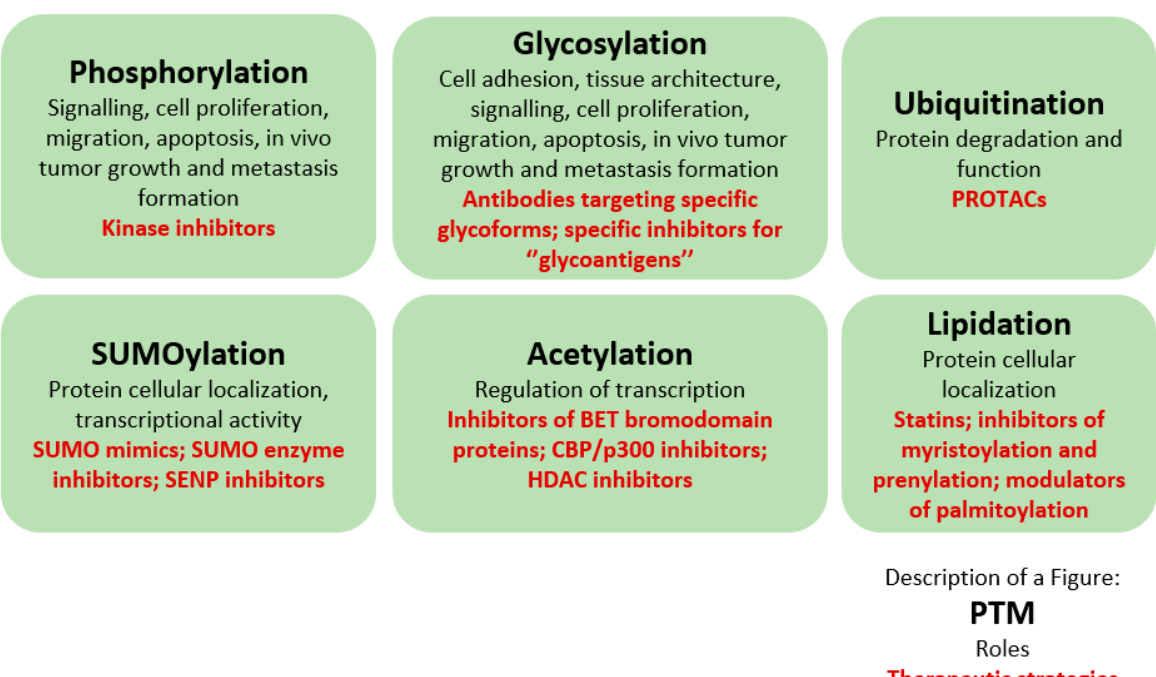
Figure 2. Post-translational modifications, their involvements in cellular processes and therapeutic opportunities. Since kinases are the driving proteins in both cancer cell growth and dissemination, tempts to develop novel anti-cancer drugs. A proteolysis targeting chimera (PROTAC) used in oncology as a first or second line therapy in various cancer types [420]. In prostate cancer, tyrosine kinase inhibitors targeting signaling pathways of EGFR, VEGFR, c-SRC pre-clinical settings but these finding are still waiting to be realized as anticancer drugs as phase III clinical trials did not produce satisfying results